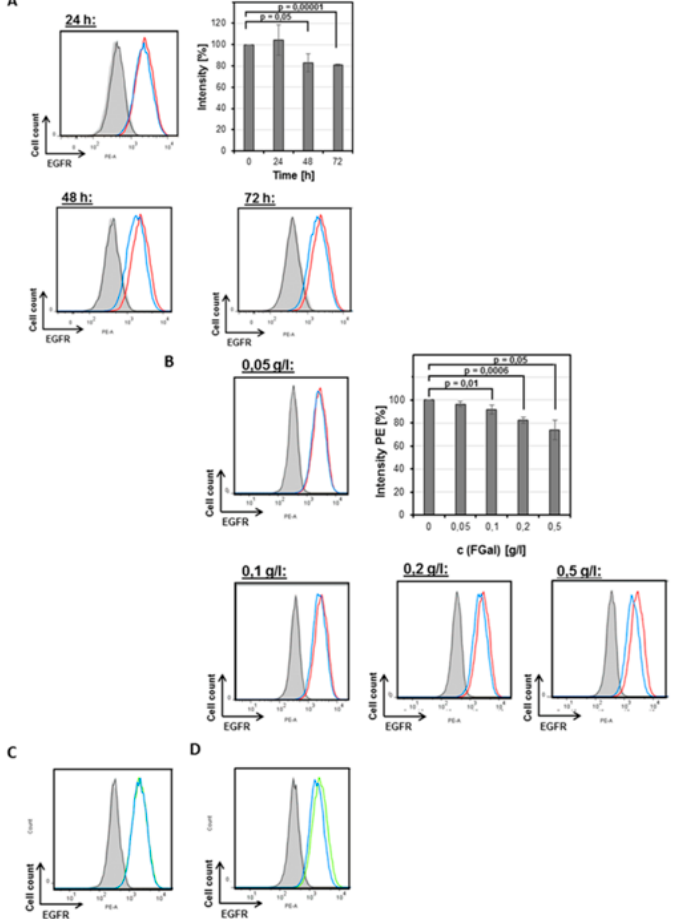
Figure 4. Plasma membrane marker glycoprotein EGFR shows reduced surface expression in fluorescence-activated cell sorting (FACS) induced by F-Gal in a time- and F-Gal concentration-dependent manner. E ff ect of varying cultivation times ( A ) and F-Gal concentrations ( B ). Control cells are shown in red, F-Gal-treated cells in blue ( A , B ). ( C ) Competitive e ff ect of increased galactose concentration (4.5 g / L) in the presence of 0.5 g / L F-Gal. Control cells in low-Glc / high-Gal medium without F-Gal are shown in green, cells treated with F-Gal in blue. ( D ) Rescue e ff ect by increased F-Gal concentration (1 g / L) in the presence of 4.5 g / L galactose. Control cells without F-Gal in low-Glc / high-Gal medium are shown in green, cells treated with F-Gal in blue.